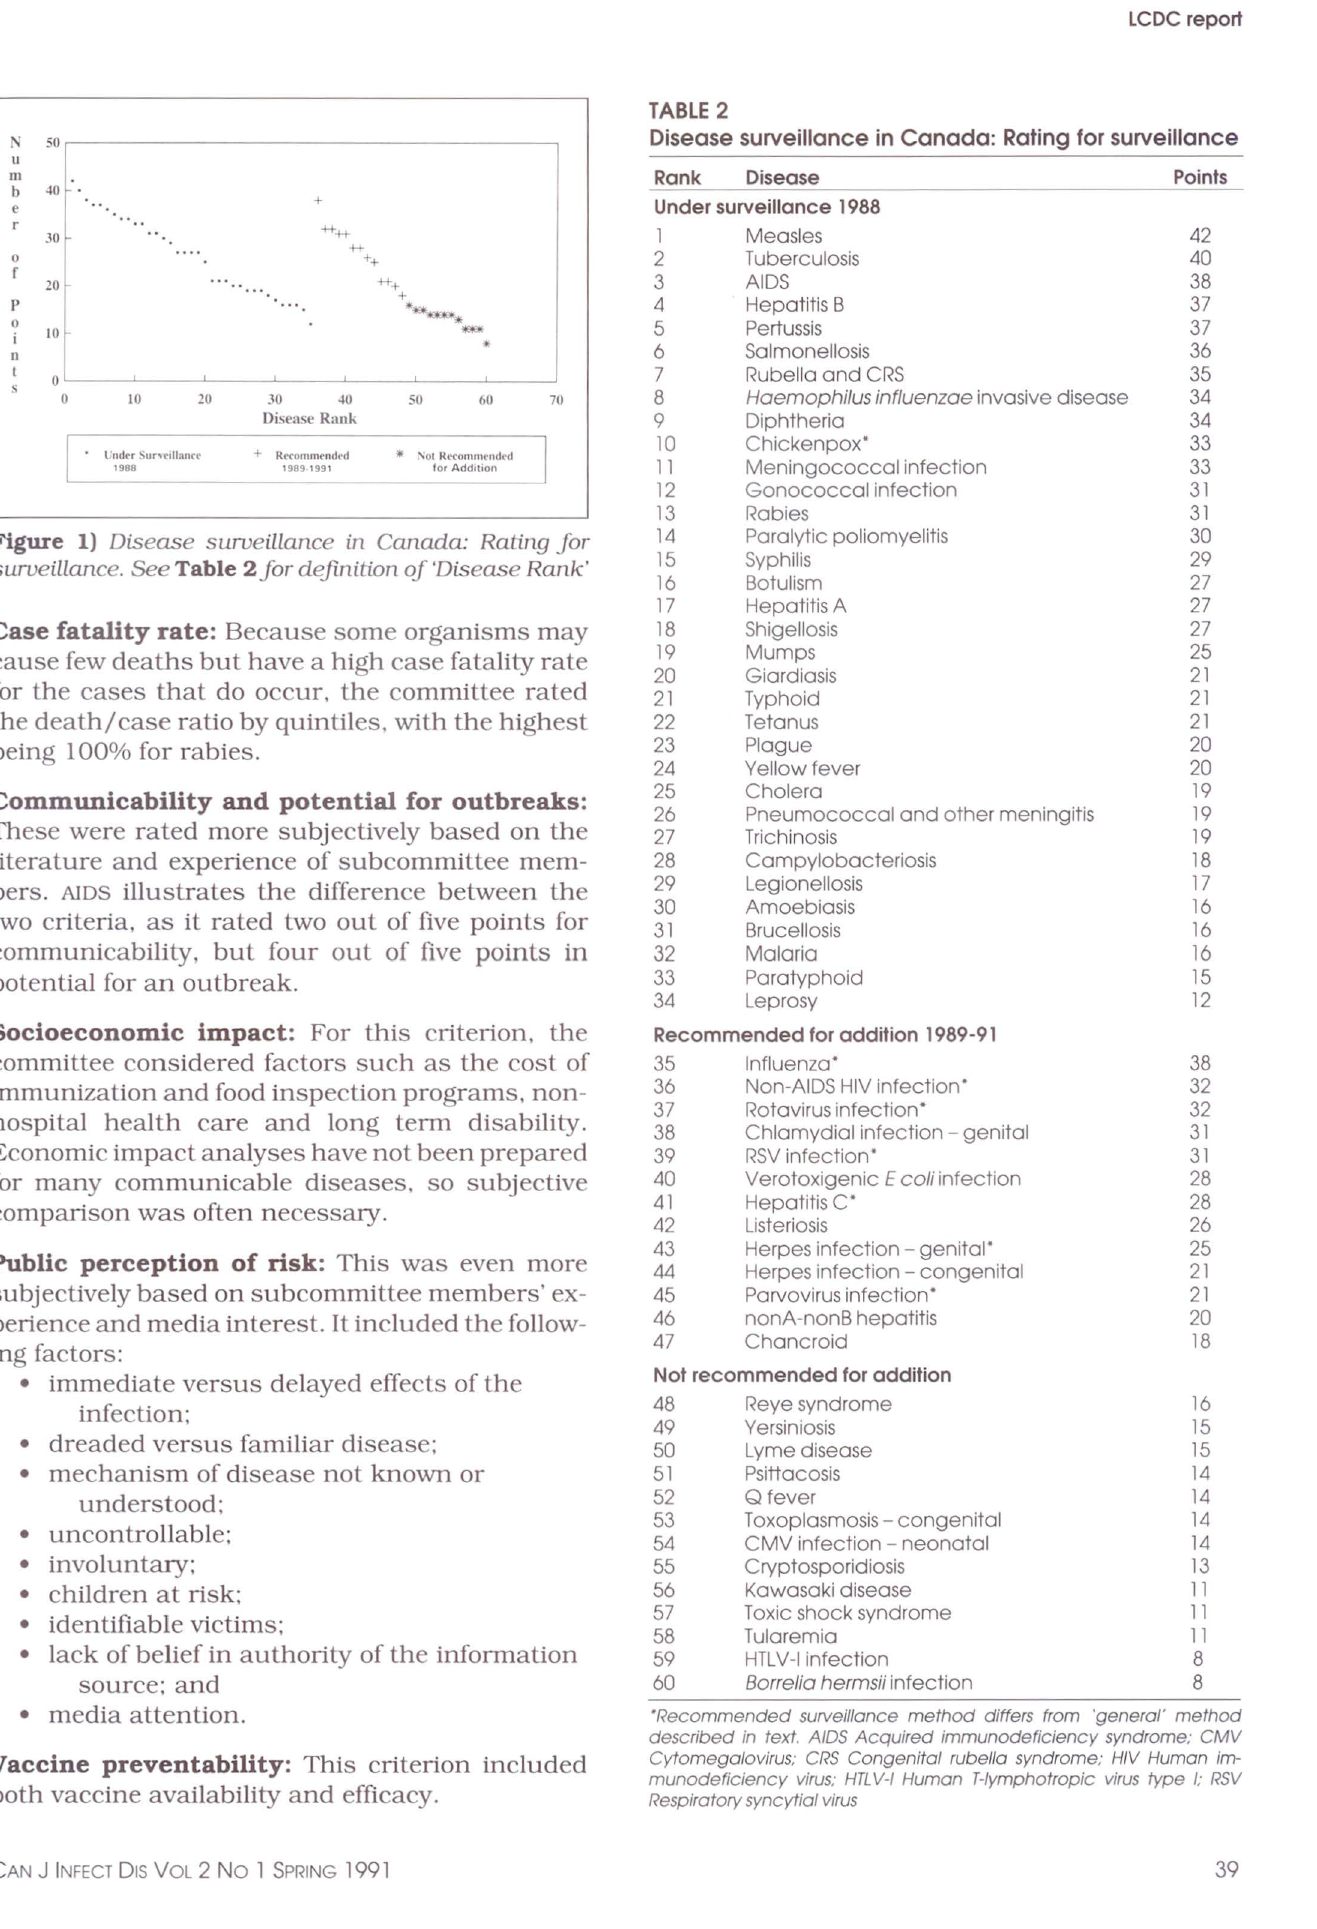
Figure 1) Disease surveillance in Canada: Rating for